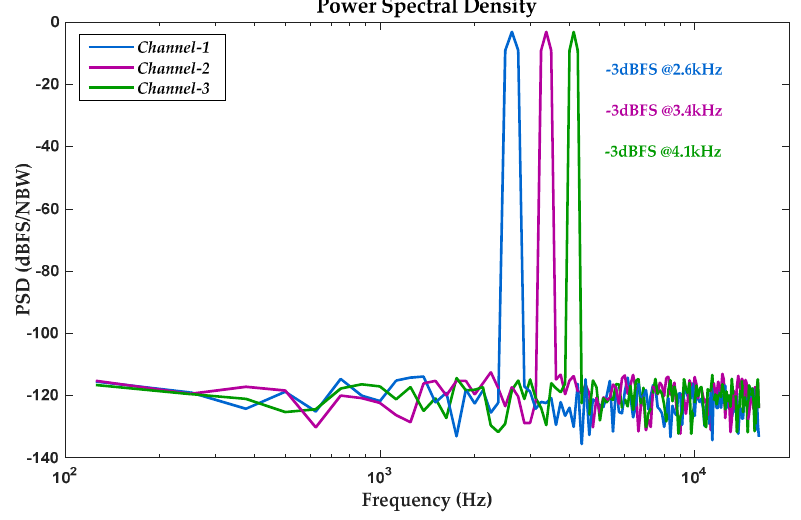
Figure 17. Measured output PSD of triple-channel ADC on 256 samples.